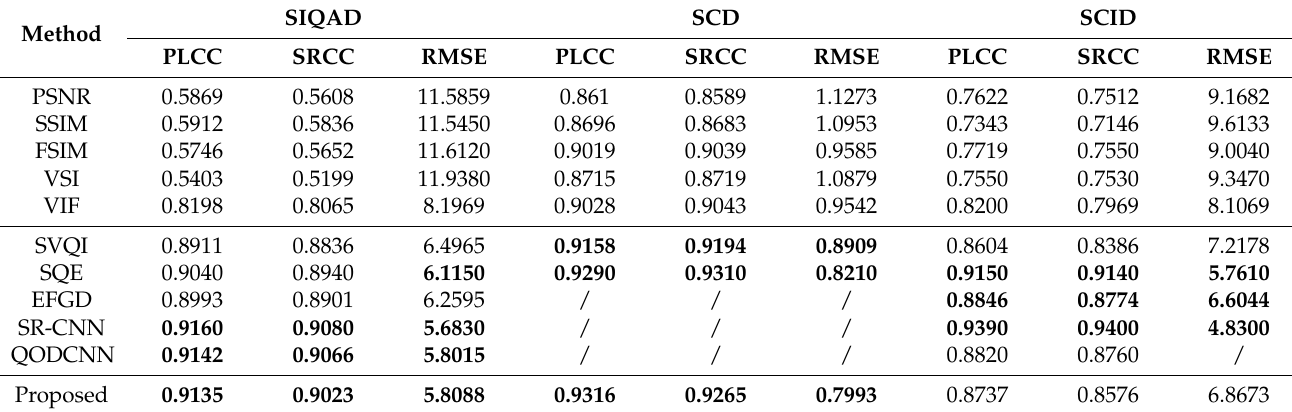
Table 2. Experimental results of the proposed and other FR-IQA methods on SIQAD, SCD, and